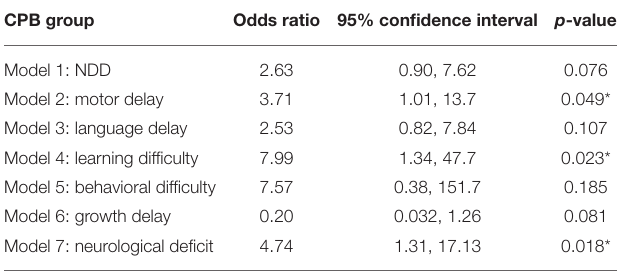
TABLE 4 | Univariate exact logistic regression models: the effect of group on the neurodevelopmental outcomes. CPB group